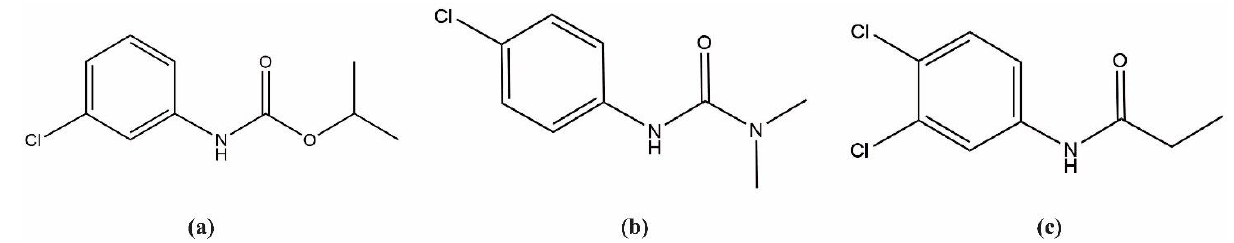
Figure 1. Chemical structure of ( a ) Chlorpropham; ( b ) Monuron; ( c )